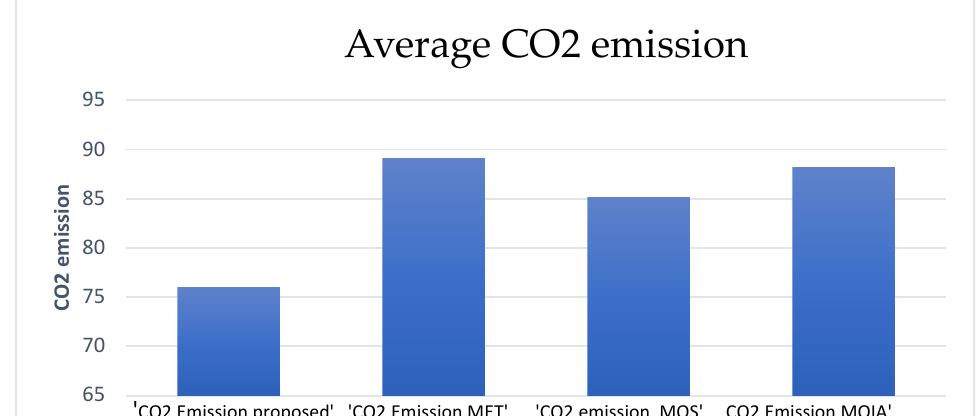
Figure 5. Average CO2 emissions of proposed vs. state of the art techniques.